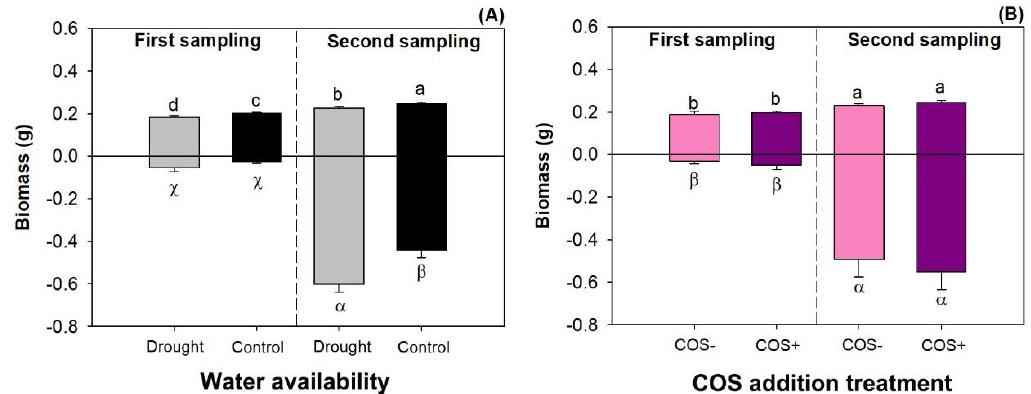
Figure 2. Biomass accumulation in two harvests of Buddhist pine ( Podocarpus macrophyllus ) seedlings exposed to contrasting water availabilities (drought vs. irrigated control) ( A ) and chitosan oligosaccharide (COS) addition (COS- vs. COS+) ( B ). Different letters indicate a significant difference according to Tukey’s test at the 0.05 level. Lower-case letters represent shoot biomass; Greek letters represent root biomass. Error bars stand for standard errors.